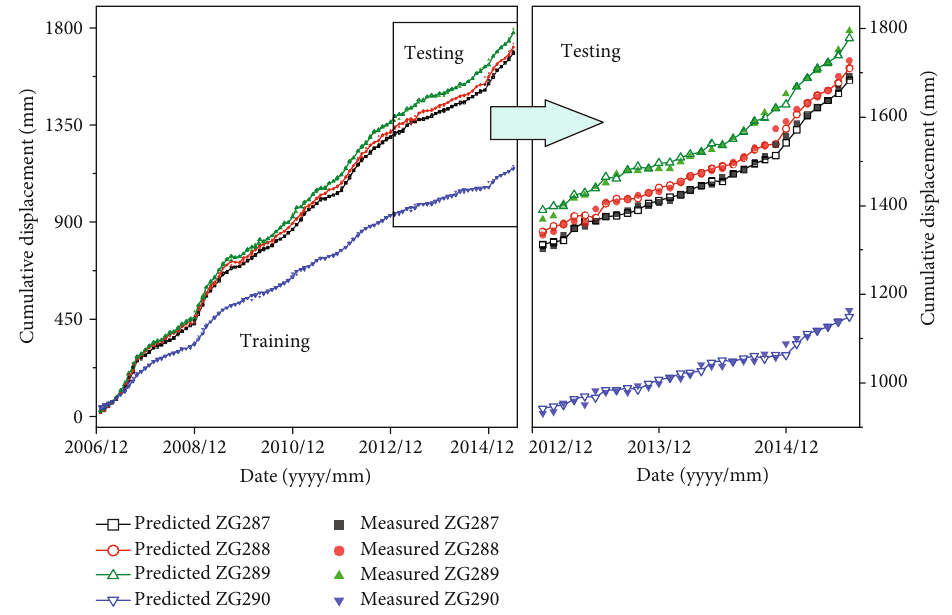
Figure 7: Actual value and point prediction value of the B-LSSVM